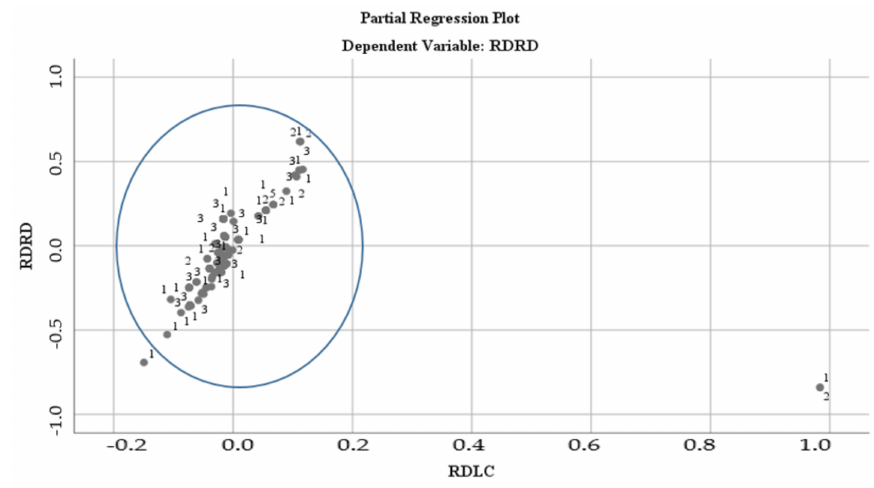
Figure 16. Regression analysis for